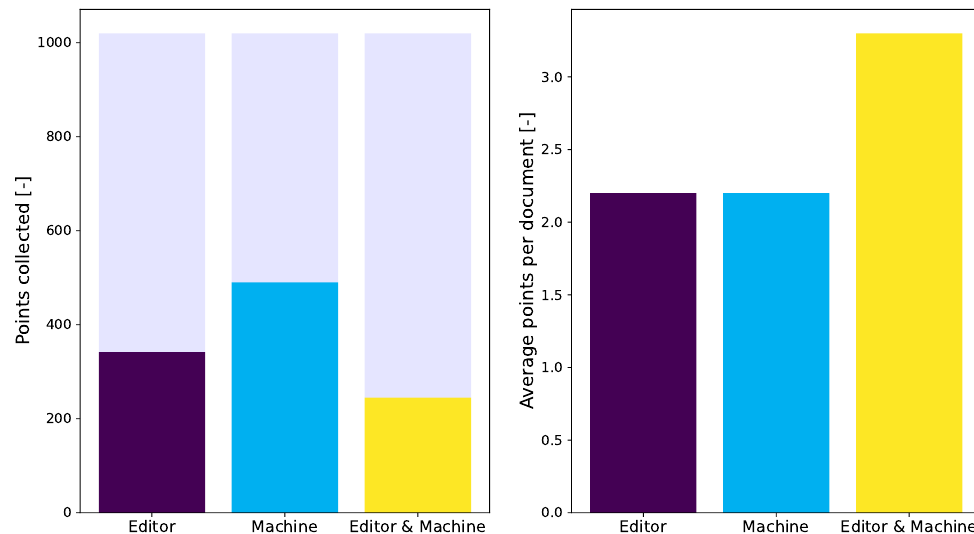
Figure 8. Comparison of performances: points collected ( left ) and average points found per document ( right